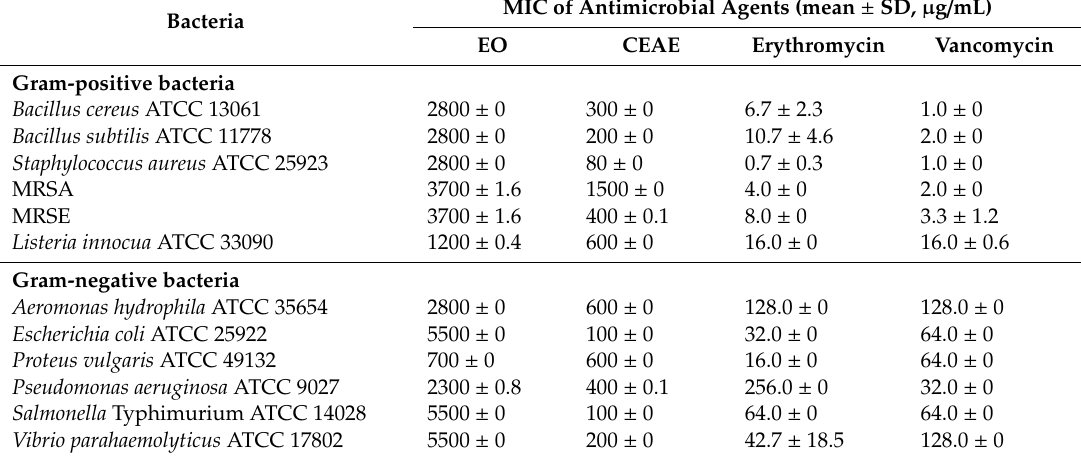
Table 3. Antimicrobial activity of S. griseorubens MPT42-CEAE and L. cubeba fruit EO against microbial strains including pathogens. MIC of Antimicrobial Agents (mean ± SD, µ g / Bacteria